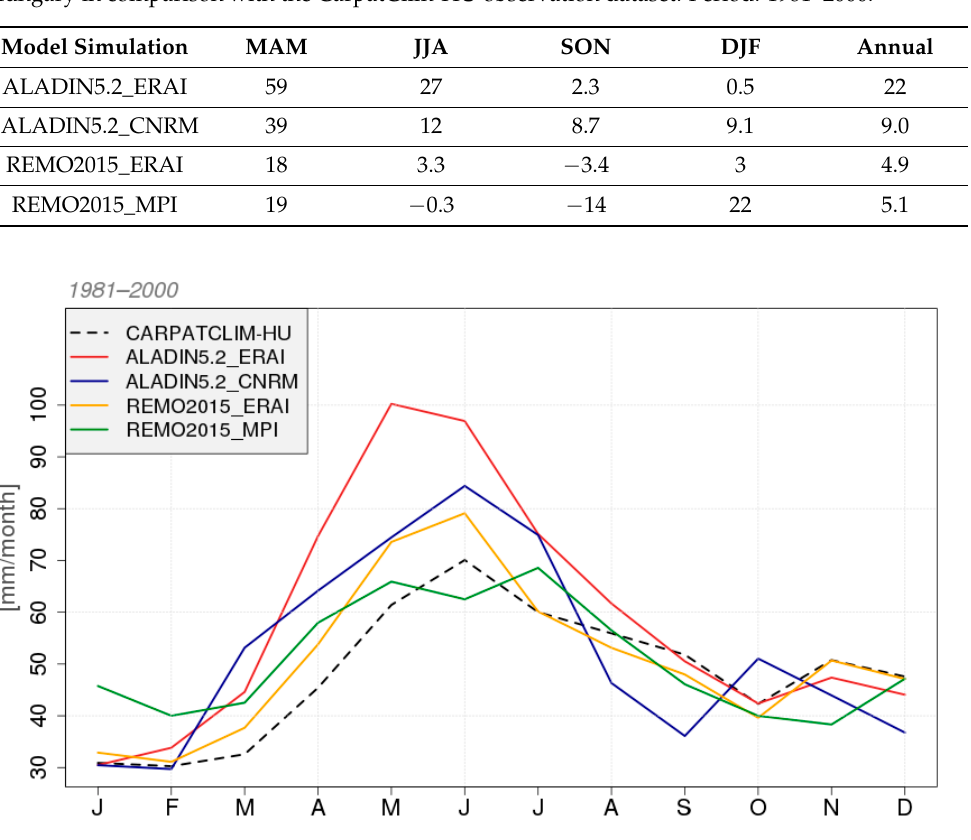
Table 6. Relative bias of seasonal and annual precipitation (%) of the four model simulations over Hungary in comparison with the CarpatClim-HU observation dataset. Period: 1981–2000.